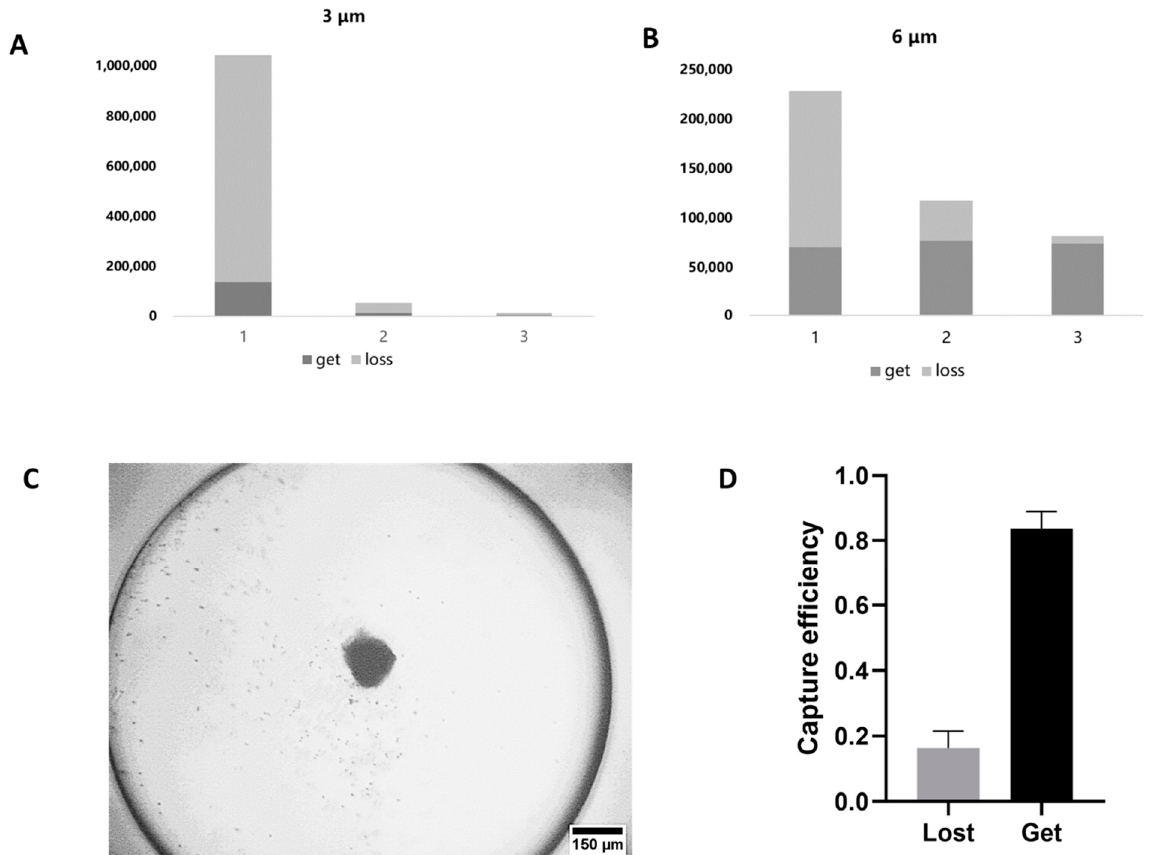
Figure 5. Verification of the microparticle-isolation module. ( A , B ) The number of microparticles with the diameter of 3 µm ( A ) and 6 µm ( B ) got and lost by acoustic resonance field at three different concentrations, 1: high concentration, 6 × 10 5 /mL for microparticles with the diameter of 6 µm, 1 × 10 6 /mL for microparticles with the diameter of 3 µm; 2: medium concentration, 4 × 10 5 /mL for microparticles with the diameter of 6 µm, 1 × 10 4 /mL for microparticles with the diameter of 3 µm; 3: low concentration, 2 × 10 5 /mL for microparticles with the diameter of 6 µm, 5 × 10 4 /mL for microparticles with the diameter of 3 µm). ( C ) Microscopic image of the enriched microparticles in the circular chamber. ( D ) Capture efficiency of the 6-µm microparticles in optimized concentration.